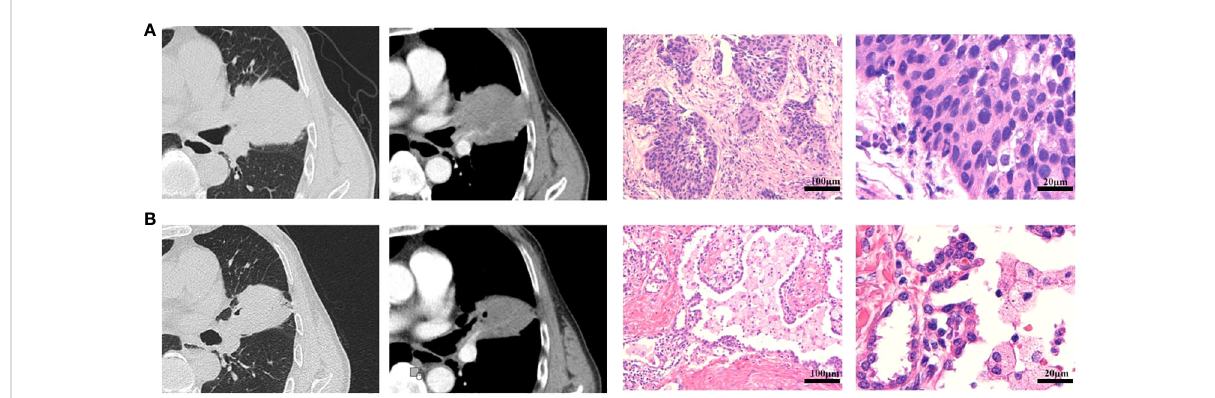
FIGURE 3 Radiological and pathological response of neoadjuvant immunotherapy plus chemotherapy. (A) The CT imaging and pathological diagnosis at baseline. (B) The CT imaging after two doses of neoadjuvant immunotherapy plus chemotherapy, and the pathological results after surgery. This was a 70-year-old male patient with smoking history, who was diagnosed as cT3N1M0 (stage IIIA) squamous cell carcinoma at baseline. After two doses of neoadjuvant immunotherapy plus chemotherapy, the patient achieved SD according to RECIST v1.1 with CT imaging assessment of 24% shrinkage of tumor. This patient underwent R0 resection with sleeve lobectomy and the pathological results with pCR. The regression bed is characterized by dense immune in fi ltrates with features of activation (tertiary lymphoid structure and dense tumor in fi ltrating lymphocytes in fi ltrates), along with features of cell